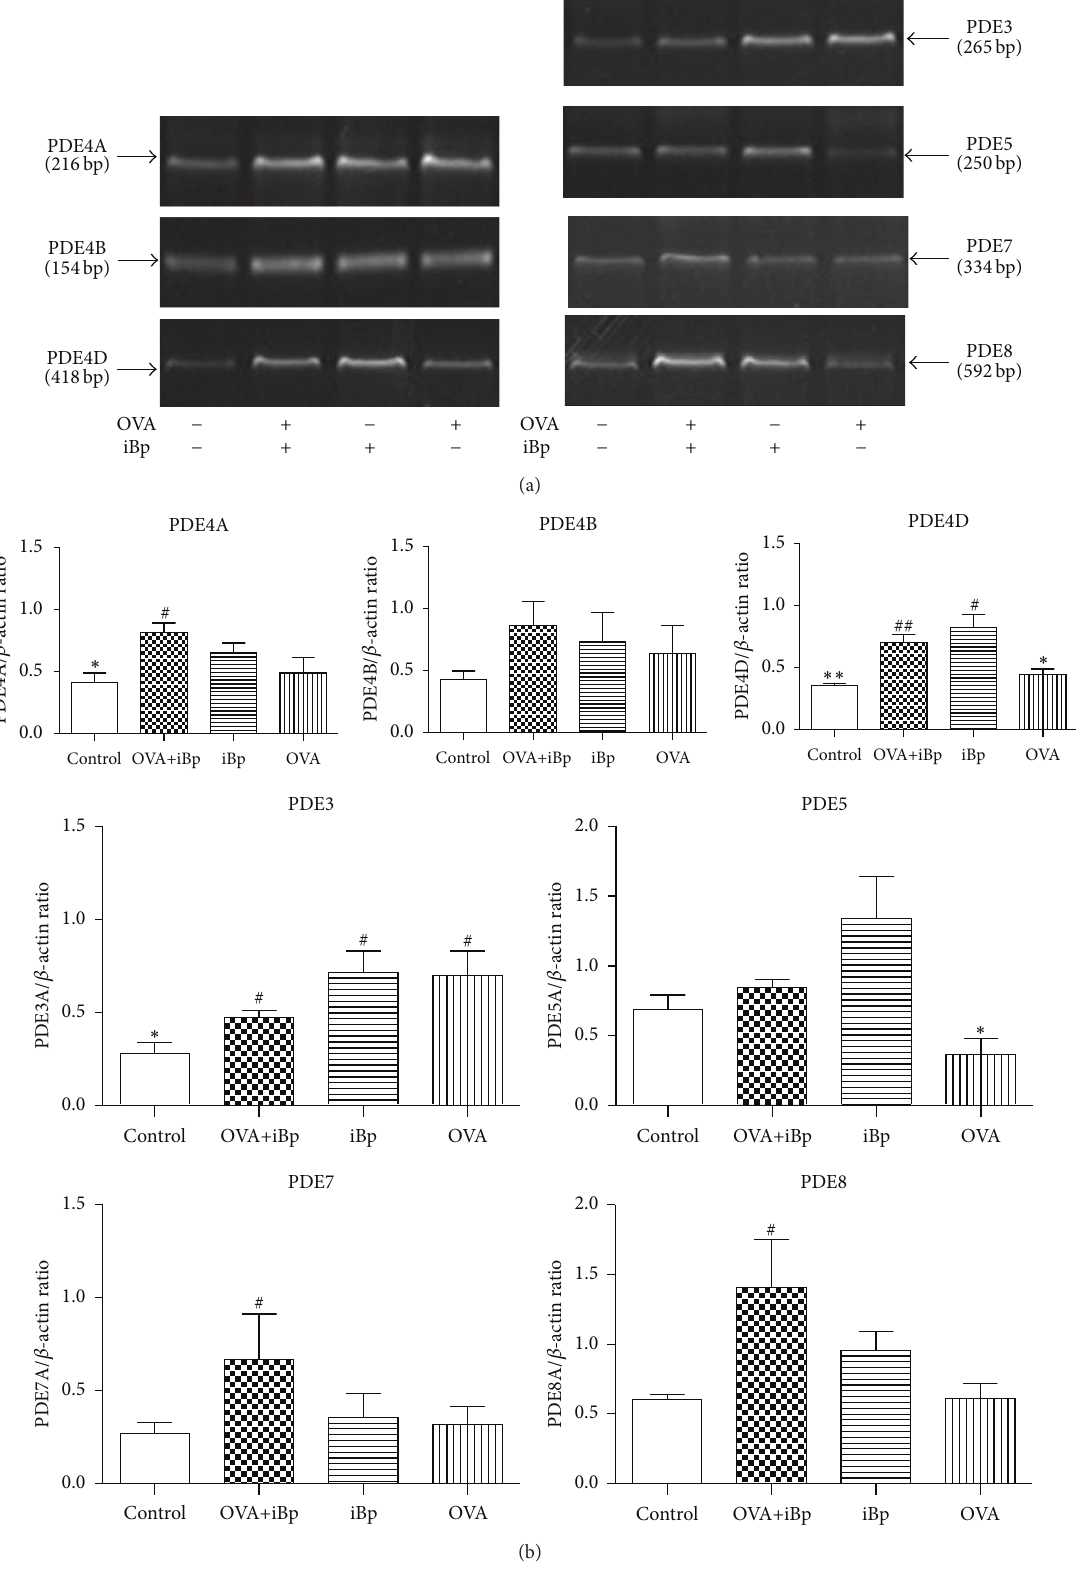
Figure 5: (a) Representative image of PDE subtype mRNA expression. (b) Levels of mRNA expression of lung PDE subtypes in normal ( 𝑛 = 8 ), OVA+iBp, iBp ( 𝑛 = 6 ), and OVA rats ( 𝑛 = 8 ). Data are expressed relative to 𝛽 -actin ( ∗ 𝑃 < 0.05 ; ∗∗ 𝑃 < 0.01 versus OVA+iBp; # 𝑃 < 0.05 ; ## 𝑃 < 0.01 versus